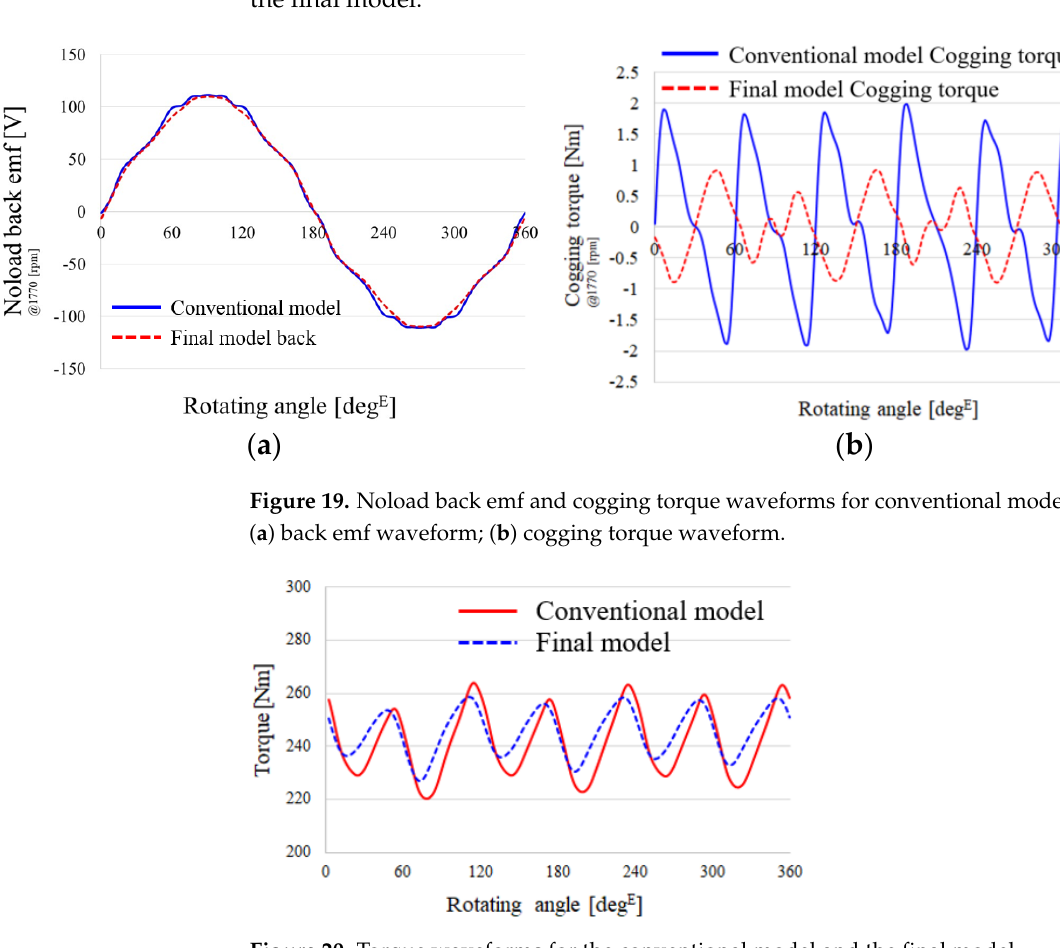
Figure 20. Torque waveforms for the conventional model and the final model. Table 2. Conventional model and final model performance comparison.